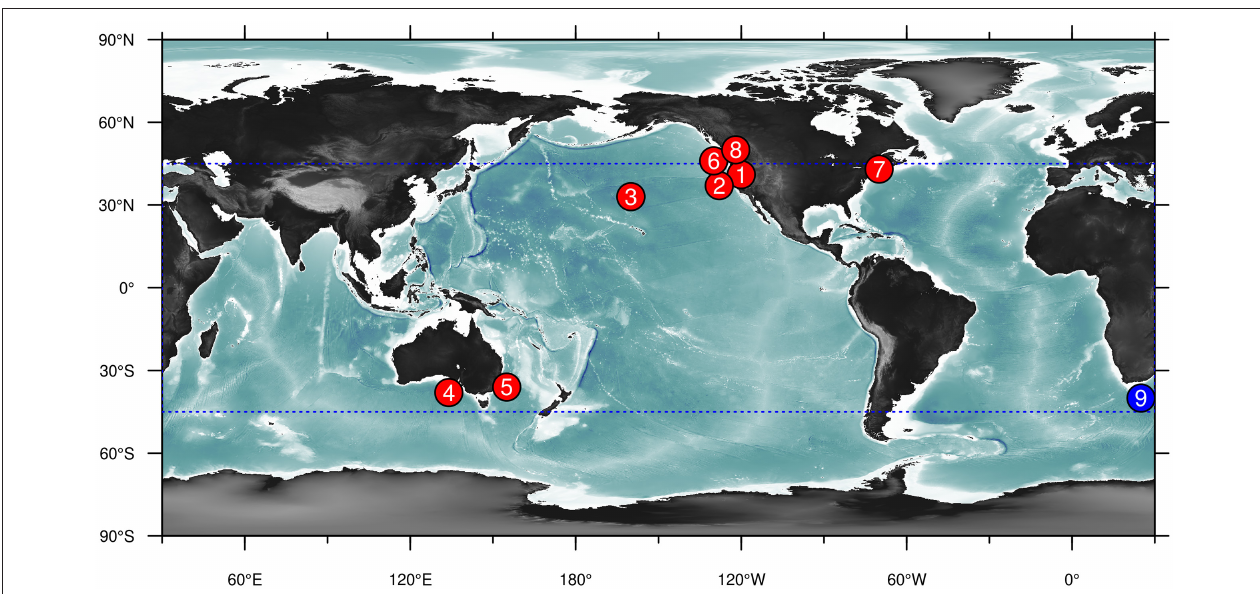
FIGURE 1 | Map of known examples of marine ecological nowcast and forecast products listed in Table 1 . Details of these products are given in this table for the corresponding number. Note that the Coral Reef Watch forecast product (number 9, blue circle) covers the globe between 45 ◦ N and 45 ◦ S (dotted blue